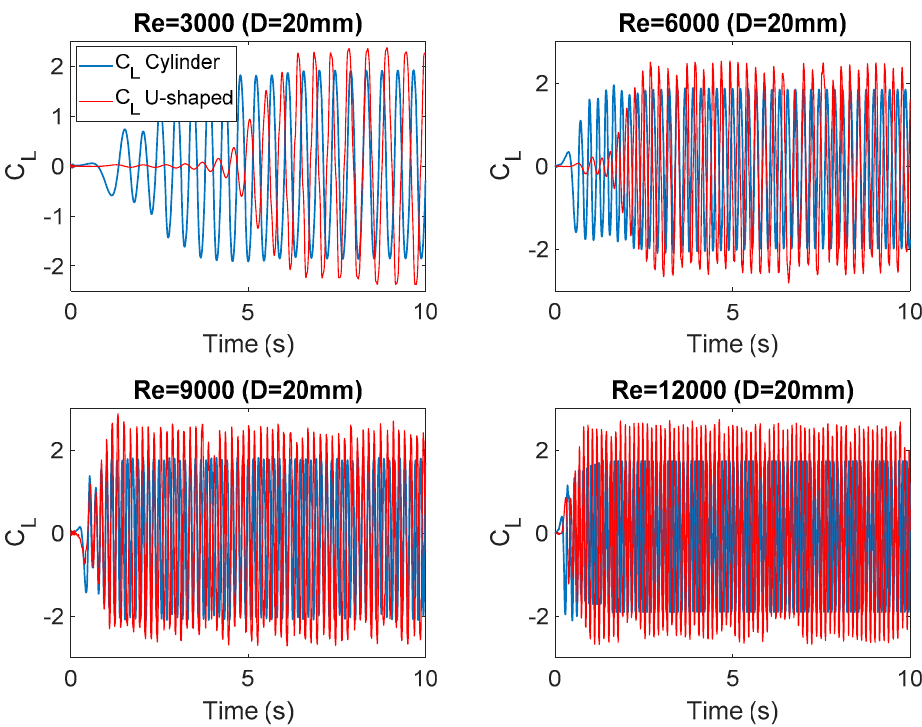
Figure 5. Evolution of the lift coefficient at each Reynolds number (D = 20 mm).